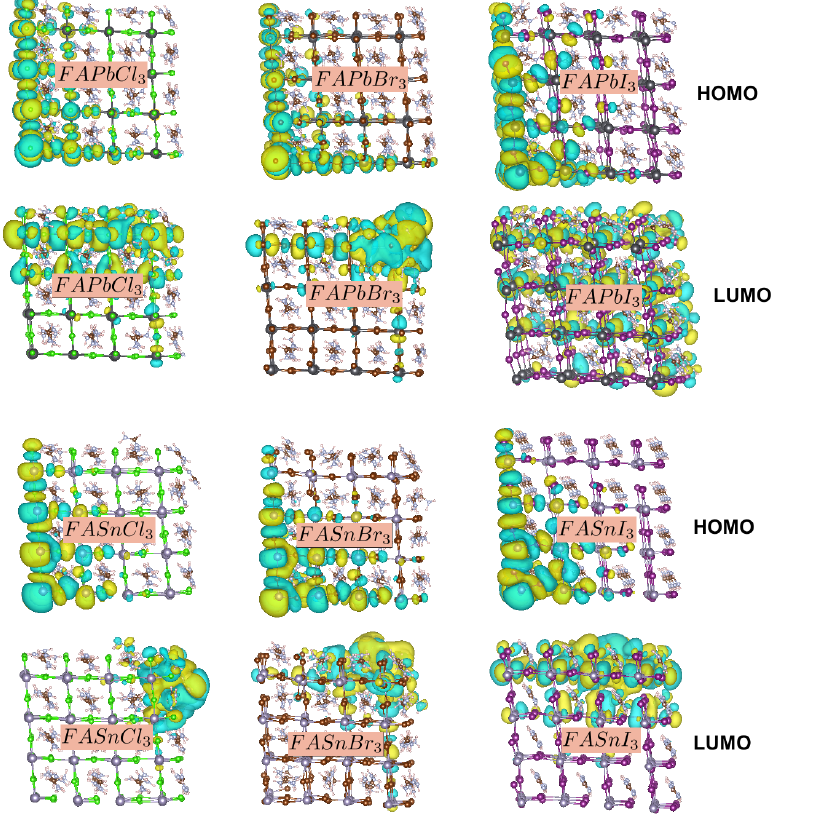
Figure 7. Plots of the HOMO and LUMO molecular orbitals for the case of 3 × 3 × 3, FABX 3 nanoparticles. In all cuboids, the atom residing in the bottom right corner corresponds to the X anion, and the remaining color corresponds to the B